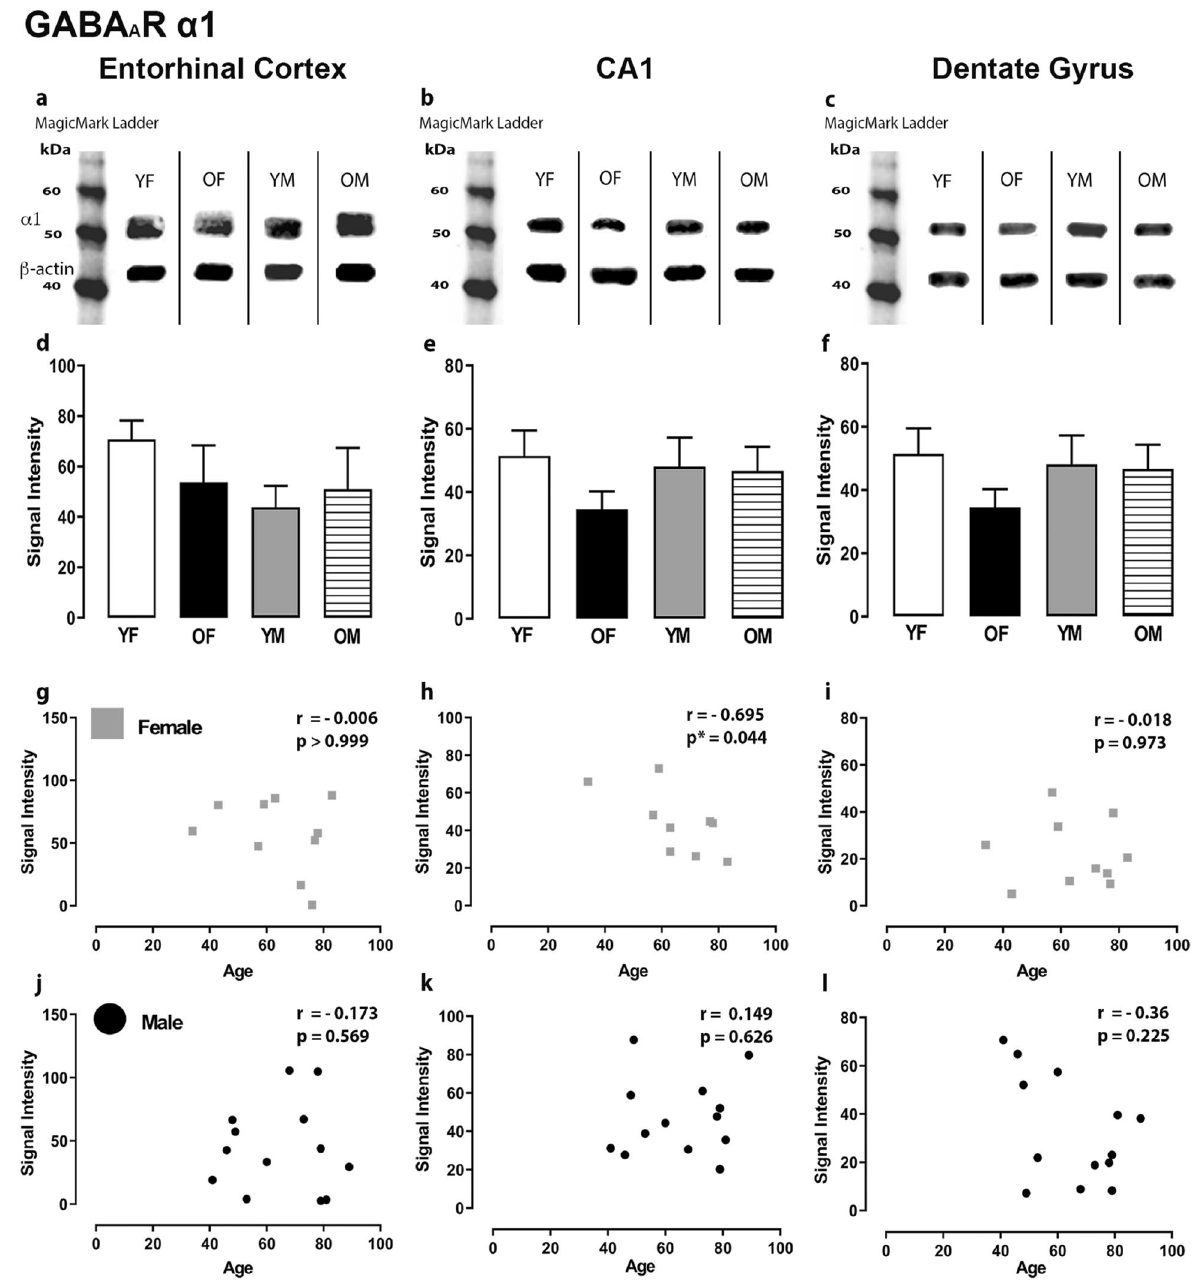
Figure 1. Expression of the GABA A R α1 subunit in the entorhinal cortex, hippocampal CA1 region and dentate gyrus. ( a , b , c ) Representative immunoreactive Western Blot bands from younger female (YF), older female (OF), younger male (YM) and older male (OM) tissue homogenates of the ECx, CA1 and DG regions, following incubation with GABA A R α1 antibody. GABA A R α1 and corresponding β-actin band (α1 band size- ~ 52 kDa, β-actin band size ~ 42 kDa) are shown. Each lane was loaded with 20 µg of protein. ( d , e , f ) Signal intensity graphs for each group comparing GABA α1 Western Blot band was measured and normalised to their corresponding β-actin signal for each age group. The data is graphed as mean ± SEM (N = 4–7). ( g , h , i , j , k , l ) Correlation graphs for males and females plotting the relationship between age and signal intensity of GABA α1